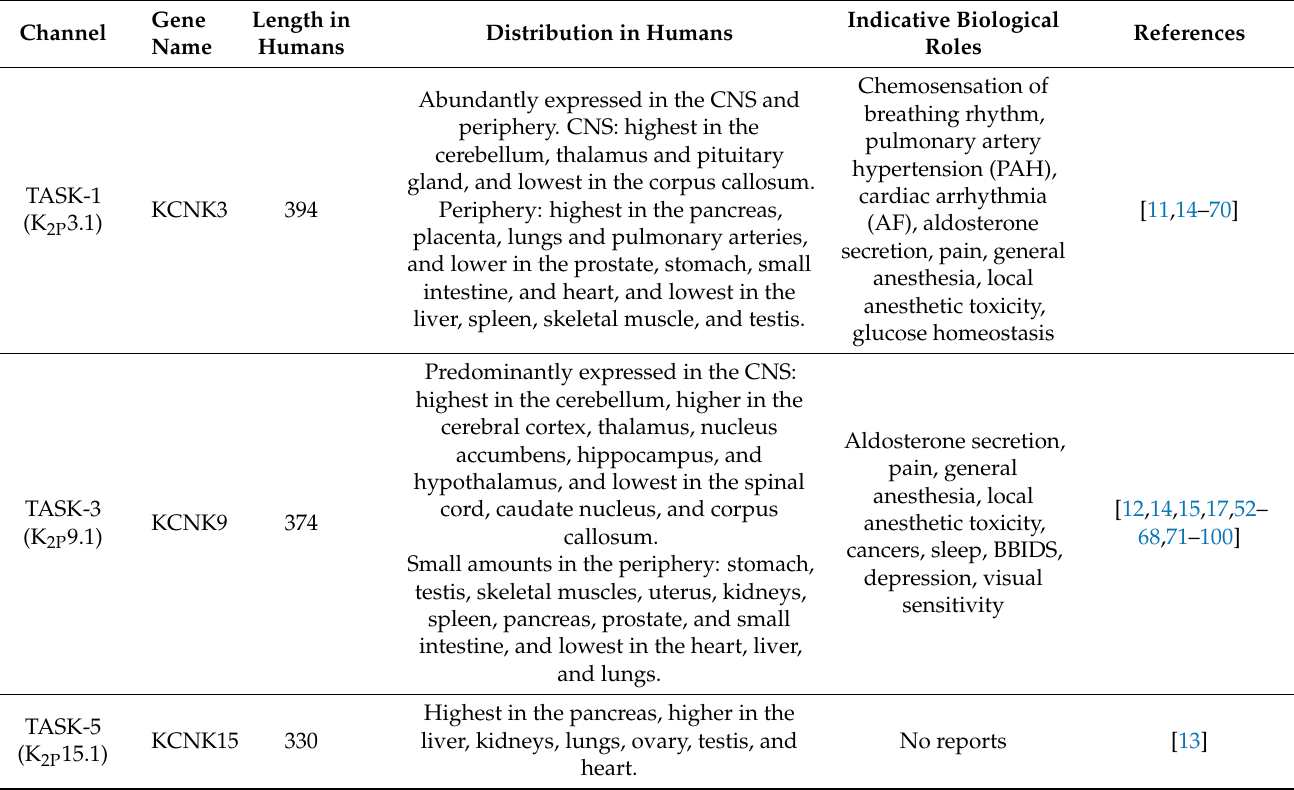
Table 1. The classification and simple comparisons of mammalian TASK